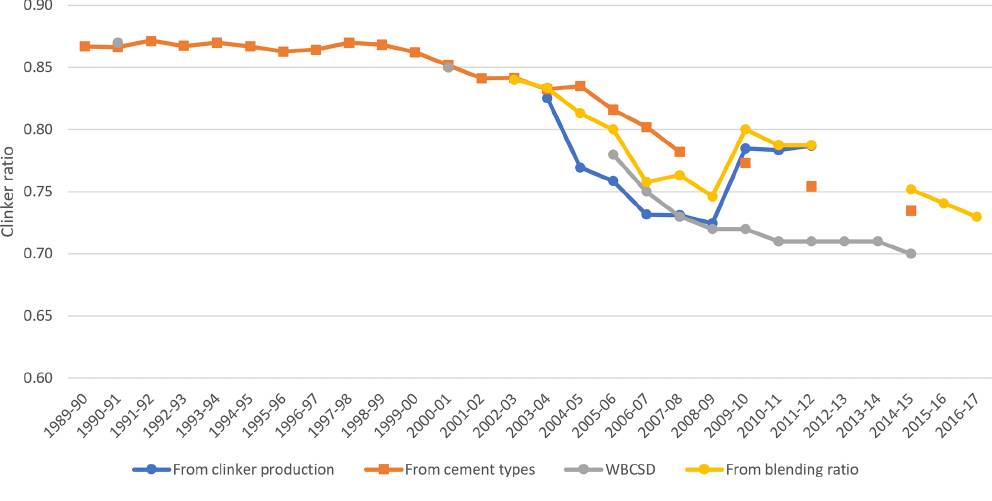
sets of estimates were available: one from the WBCSD and IEA (2013), assumed to represent 2012 and later, and another from IBEF (2005), assumed to represent 2005 and